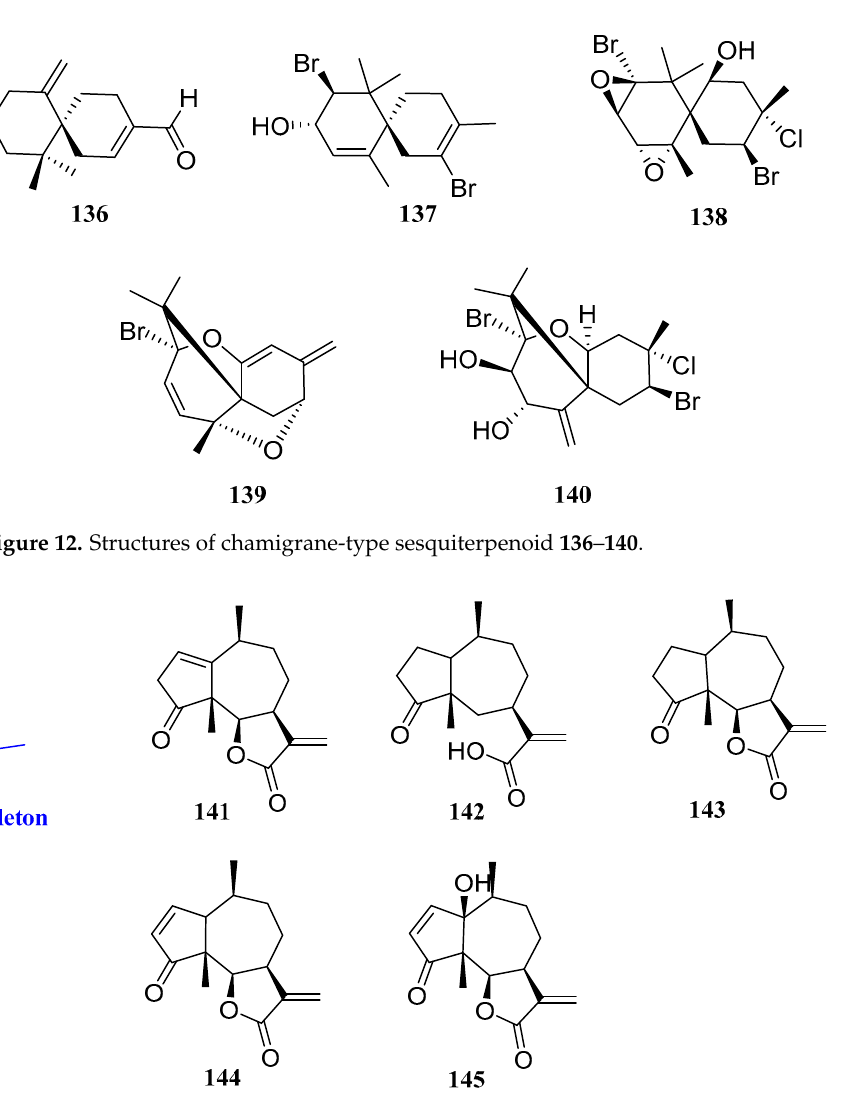
Figure 12. Structures of chamigrane - type sesquiterpenoid 136 – 140 .